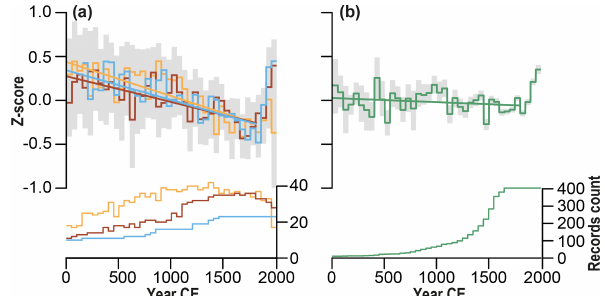
Figure 2. Compilation of NH temperature-sensitive proxy records from the PAGES2k initiative. (a) Fifty-year binned composites from 49 marine sediment (orange), 36 lake sediment (red), and 23 glacier ice (blue) records expressed in standard deviation units. Straight lines highlight the pre-industrial temperature trends (1–1800CE) and lower graphs show the corresponding temporal distribution of the records. Gray shadings indicate 95% bootstrap confidence inter- vals with 500 replicates. Panel (b) same as in (a) for 402 tree-ring records.